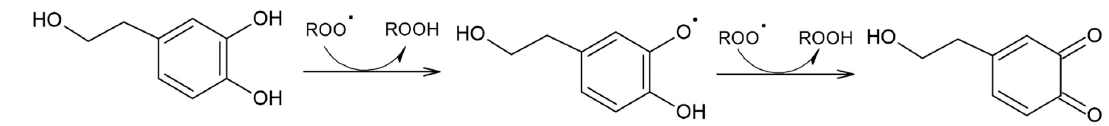
Figure 8. Free radical scavenging mechanism exerted by hydroxytyrosol (HT).